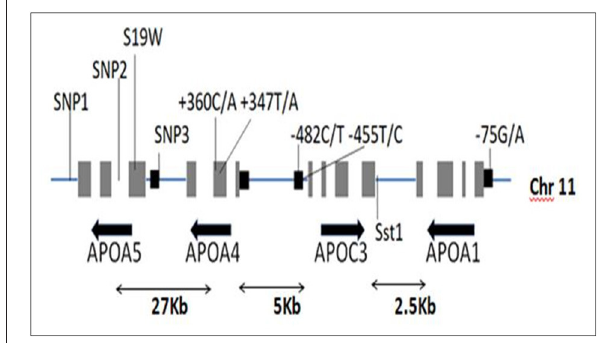
FIGURE 1 | The APOA1/C3/A4/A5 gene cluster residing on chromosome 11 spanning various polymorphisms.